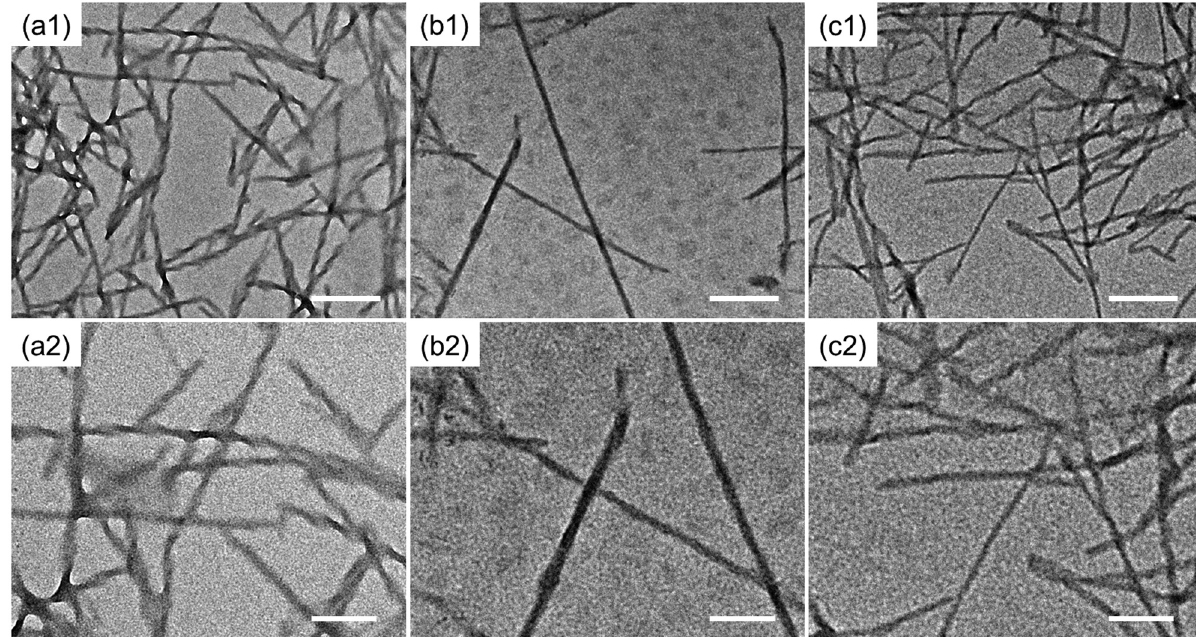
Figure 1: TEM images of ( a1 and a2 ) KRW6, ( b1 and b2 ) KRW6 - F, and ( c1 and c2 ) KRW6 - FF peptide self - assemblies. Scale bars: ( a1 – c1 ) 200 nm and ( a2 – c2 ) 100